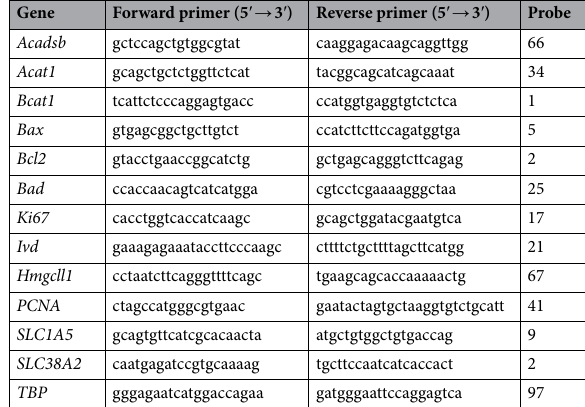
Gene Forward primer (5 ′ → 3 ′ ) Reverse primer (5 ′ → 3 ′